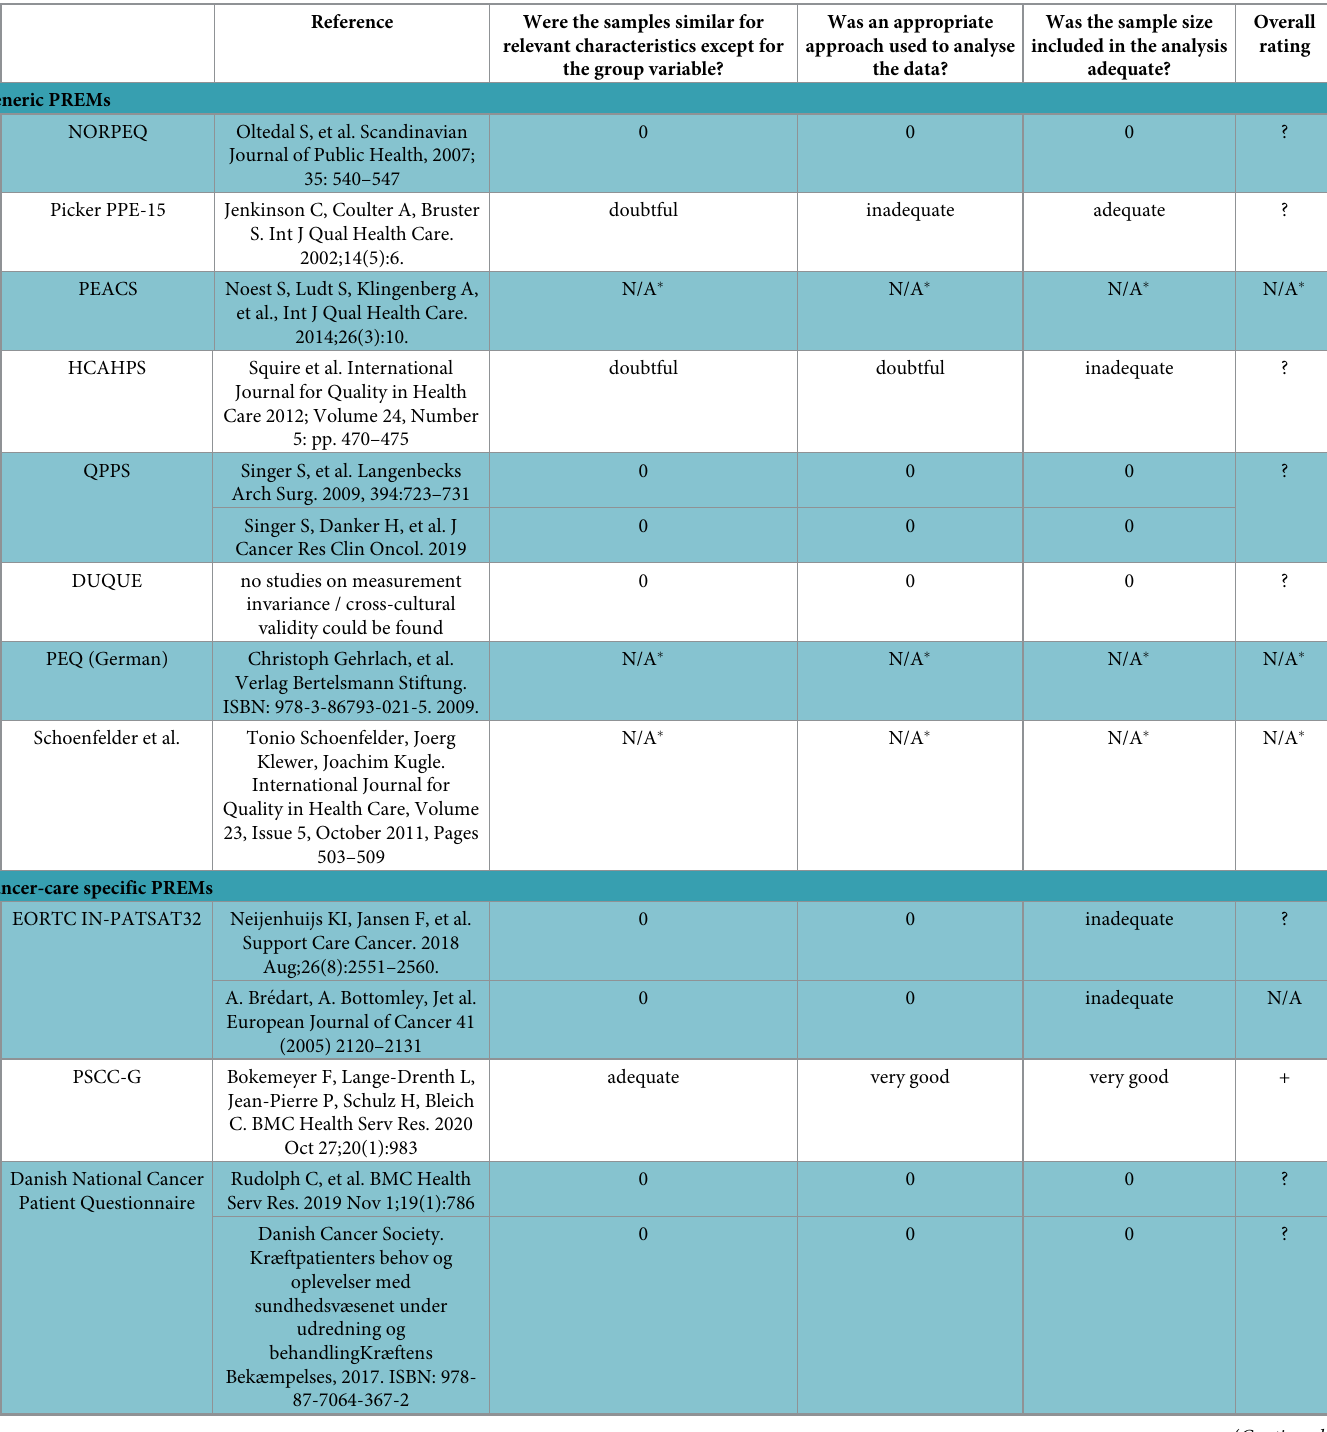
Table 7. Results of cross-cultural validity analyses of PREMs into German. Rating according to COSMIN guidelines.